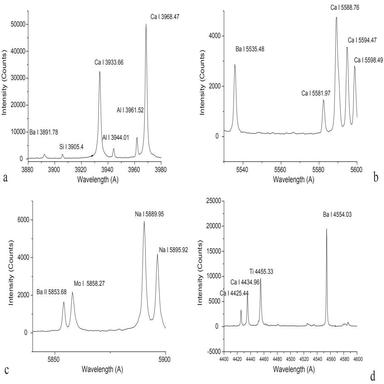
LIBS analysis of the slag sample.